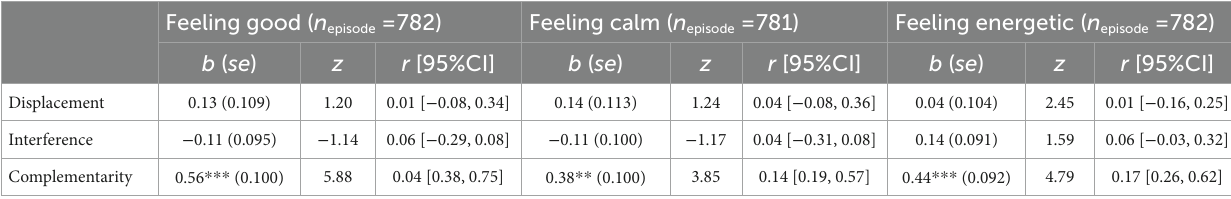
TABLE 2 Within-person associations between phone use indicators and feeling good, calm, and